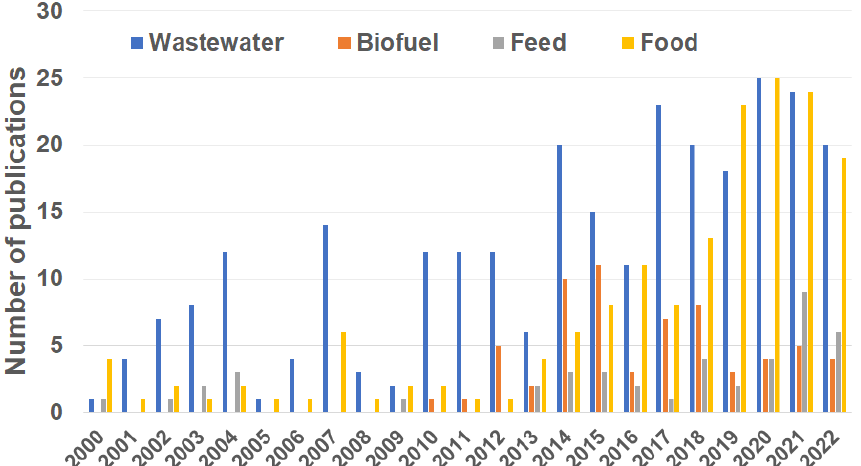
Figure 2. Publications related to duckweed research in the period 2000–2022. The total number of publications returned by the PubMed database (https://pubmed.ncbi.nlm.nih.gov, visited 3 November 2022) was 199 for “Wastewater”, 57 for “Biofuel”, 41 for “Feed”, and 147 for “Food”.